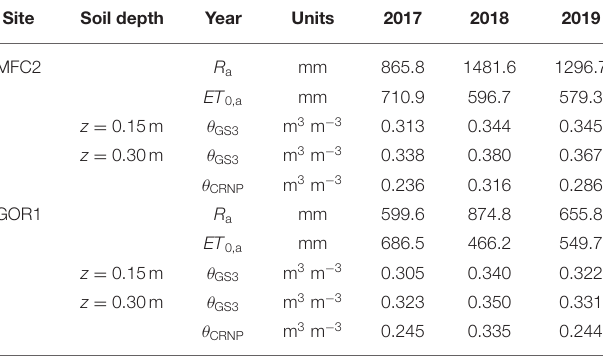
TABLE 3 | Rainfall ( R a ) and reference potential evapotranspiration ( ET 0, a ) depths on an annual basis with corresponding spatio-temporal-mean of SoilNet-based soil moisture ( θ GS3 ) at soil depths of 0.15 and 0.30m and time-averaged CRNP-based soil moisture ( θ CRNP ) at MFC2 and GOR1 in 2017, 2018, and